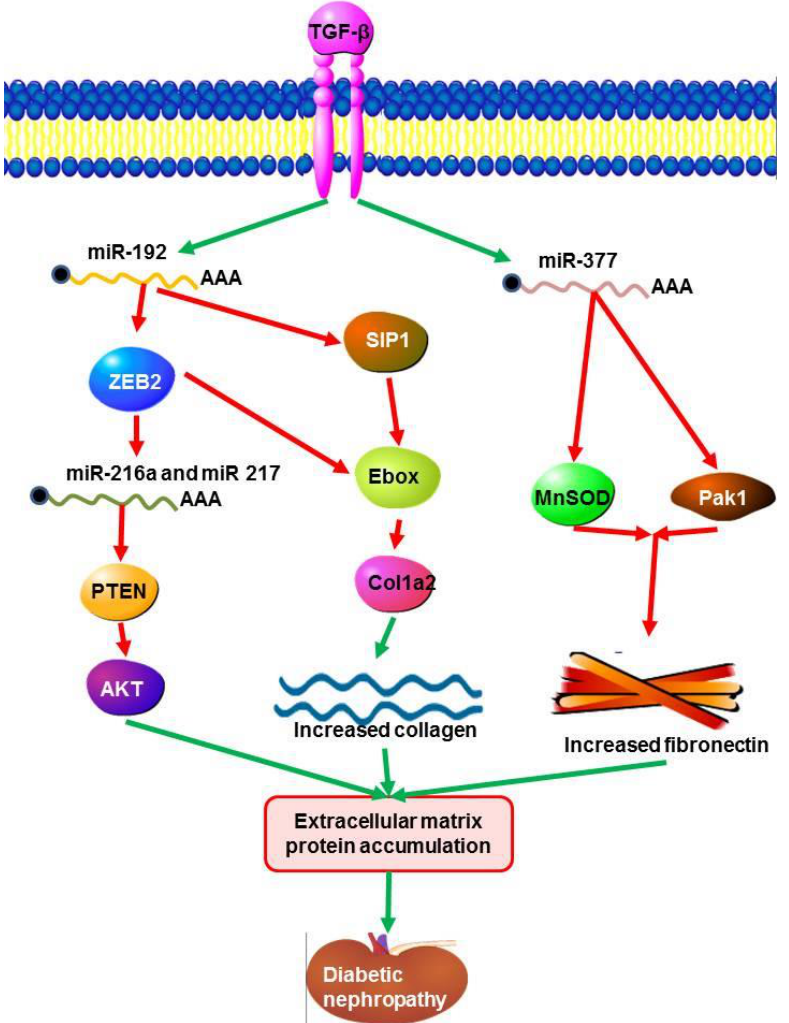
Figure 3. Signalling pathways initiated by miRNAs and TGF-β in diabetic